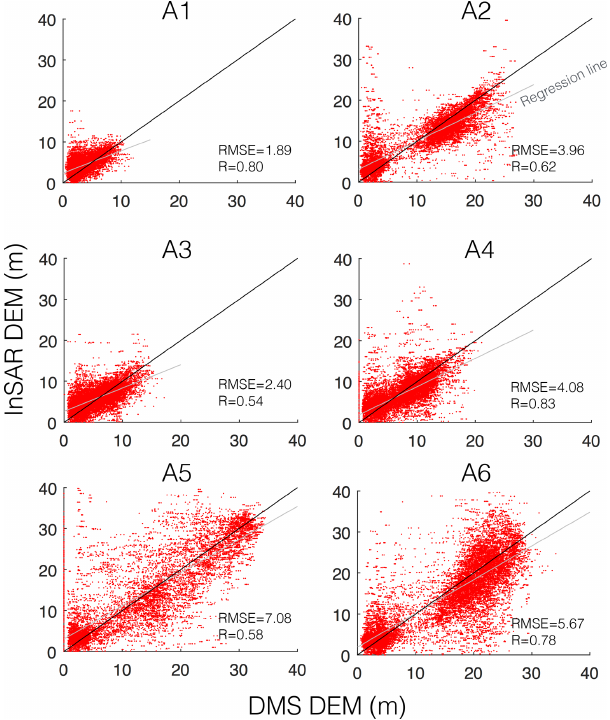
Figure 6. Correlation between InSAR DEM and DMS DEM for areas